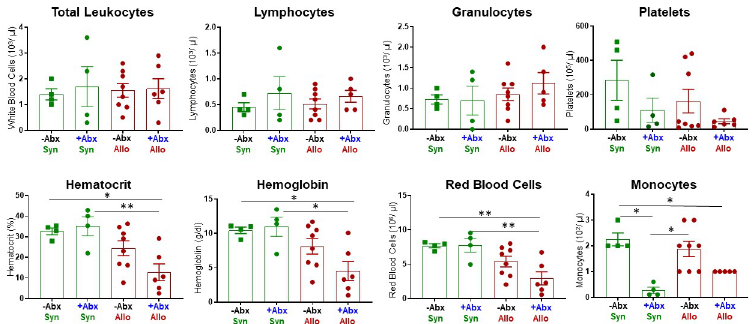
Fig 1. Complete blood cell counts (CBC). CBC analysis was quantified from EDTA-treated whole blood obtained from each mouse in the following 4 groups at 4 weeks post T cell transfer. Mice in the– Abx/Syn and - Abx/Allo groups represent–NK/RAG mice engrafted with syngeneic or allogeneic CD4 + T cells and treated with aspartame alone whereas +Abx/Syn and +Abx/Allo mice represent–NK/RAG mice engrafted with syngeneic or allogeneic T cells and treated with aspartame plus antibiotics. Asterisks ( � ) designate significant differences between groups ( � p < 0.05, �� p < 0.01).